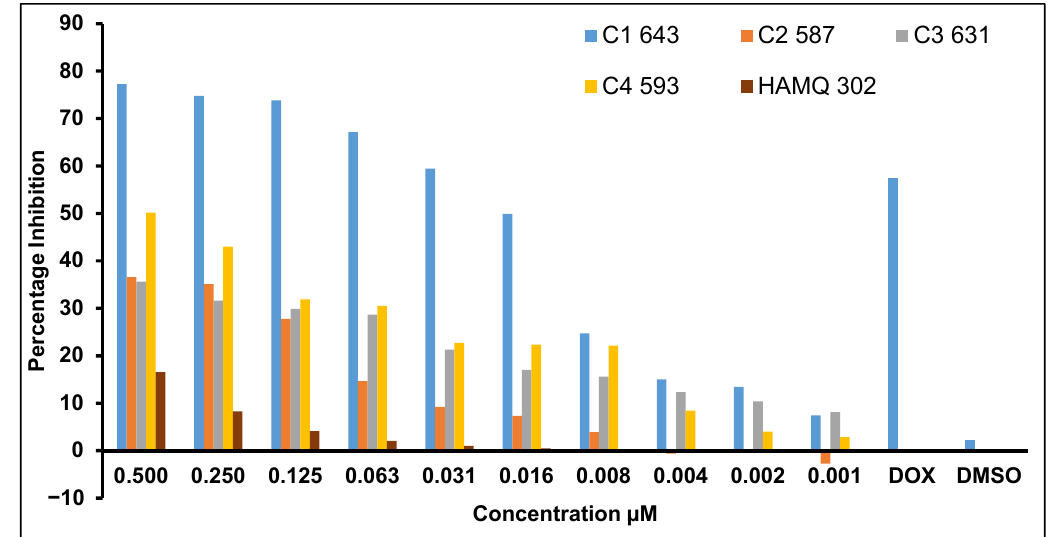
Figure 1. Sulforhodamine B colorimetric assay in colorectal cancer cell culture (HCT115) to analyze the percentage inhibition for all complexes. Doxorubicin was used as a positive control, while dimethyl sulfoxide (DMSO) was used as a vehicle control.